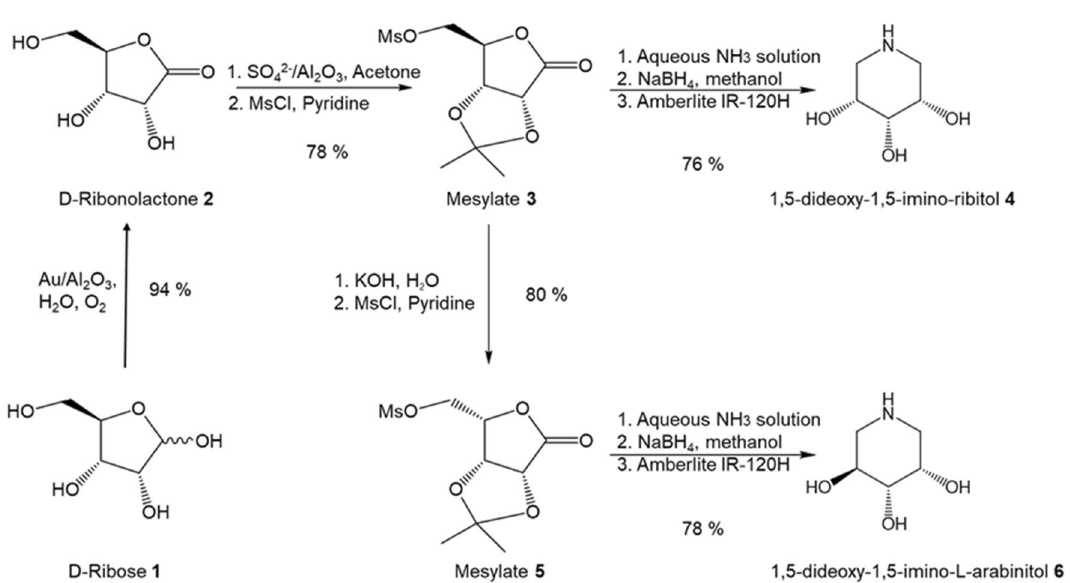
Scheme 1. Synthesis route from d-ribose to 1,5-dideoxy-1,5-imino-d-ribitol 4 and 1,5-dideoxy-1,5-imino-l- arabinitol